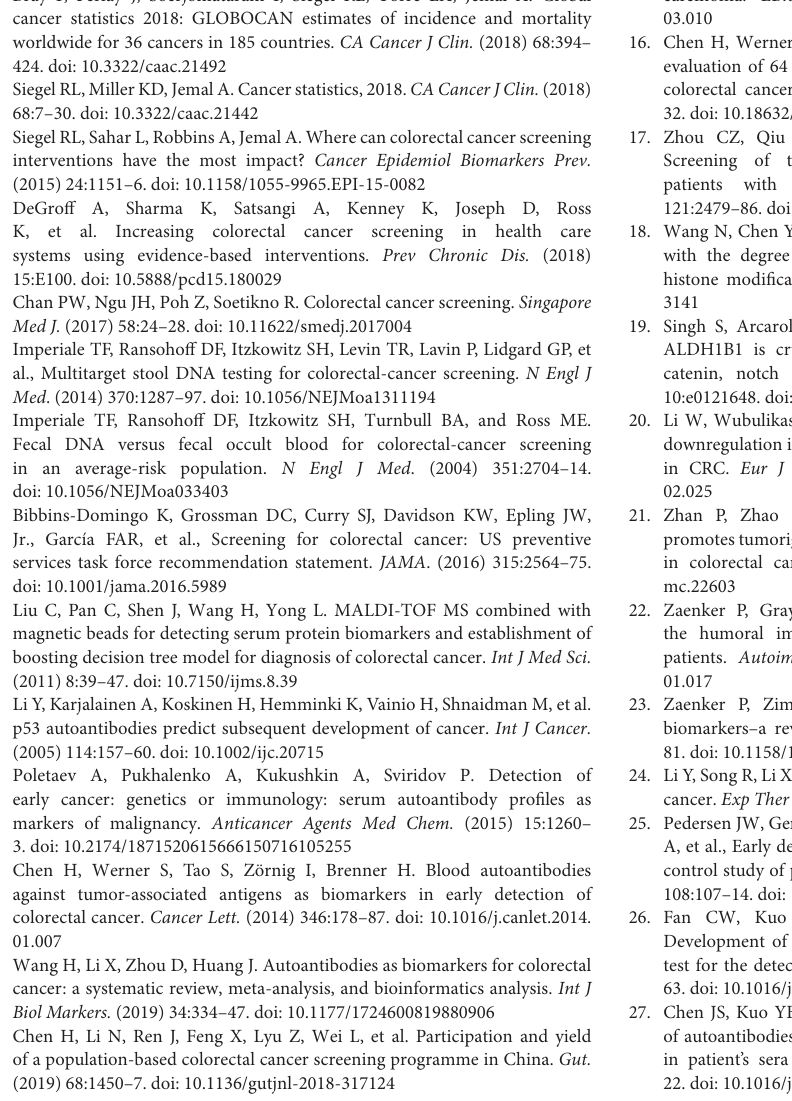
Figure S1 | Representative results of SERPA analysis of autoantibodies in sera from CRC patients and normal serum. (A) Coomassie blue-stained 2-DE of proteins isolated from CRC tissue lysates. Arrows in the 2D gel indicate the most immunoreactive spots recognized by serum from CRC patients. (B) CRC patient and (C) normal control sera. Figure S2 | SDS-PAGE to prepare the recombinant ALDH1B1 protein. 1, DNA marker; 2, uninduced lysate; 3, induced lysate; 4, supernatant of the lysate after ultrasonication; 5, precipitation of the lysate after ultrasonication; 6, flow through